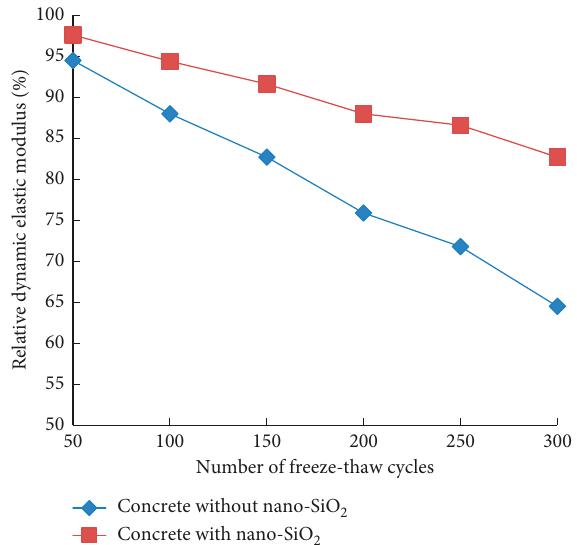
Figure 5: Change of relative dynamic elastic modulus with number of freeze-thaw